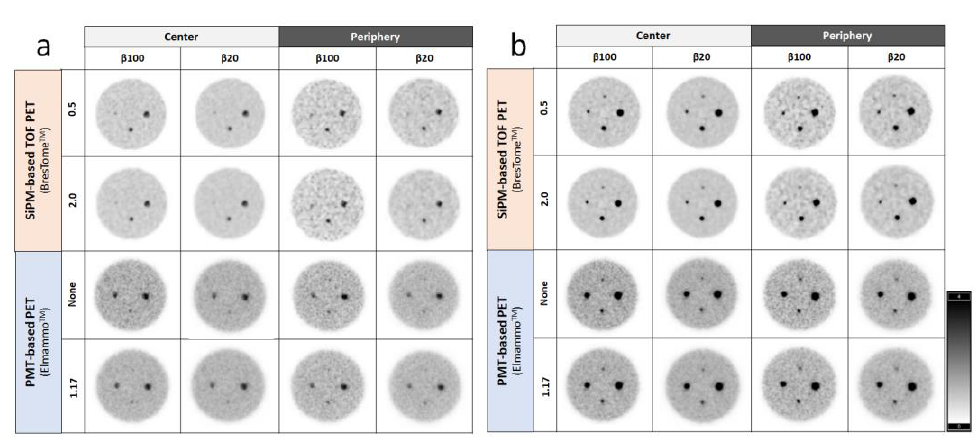
Figure 4. Representative reconstructed images obtained with the two organ-specific PET systems ( top half, SiPM-based TOF-PET; bottom half, PMT-based PET) acquired at the signal-to-background ratios (SBRs) of 4:1 ( a ) and 8:1 ( b ) at the center of the detector ( left half ) and 2 cm below the top edge ( right half ) and reconstructed by applying different β -values (100 and 20) and post-filters of 2.0 and 0.5 as the non-local means (NLM) for SiPM-based TOF-PET ( top row ), and 0 and 1.17 mm as the Gaussian filters for PMT-based PET ( left row ). The smallest of the four spheres (3 mm in diameter) was located at 12 o’clock. Note: The order of the 7.5 mm diameter and 5 mm diameter spheres is rotated between the two scanners due to an error in the phantom setup.